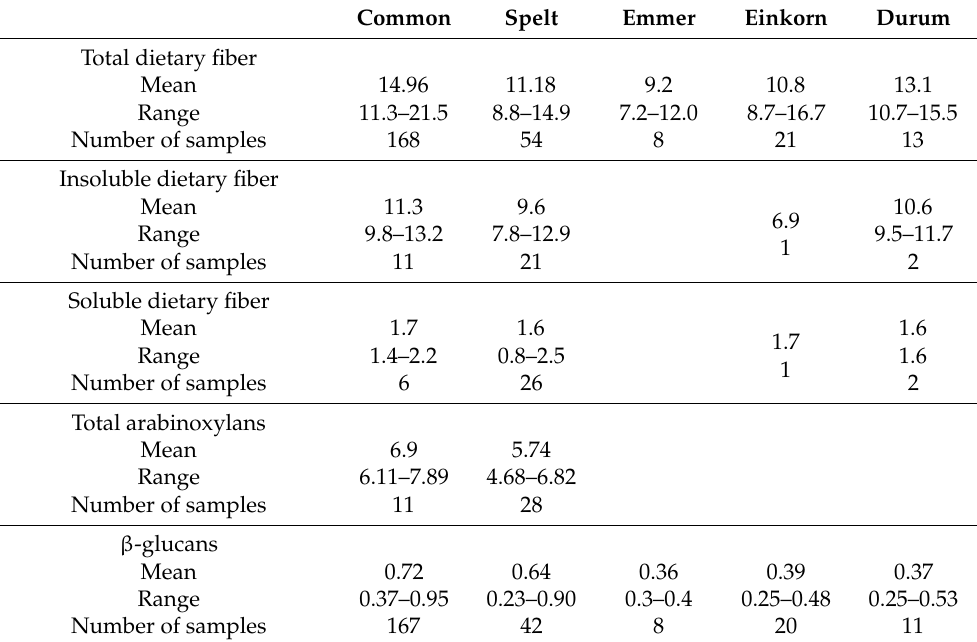
Table 3. Dietary fiber content (% dry basis) of modern (common and durum) and ancient (spelt, emmer and einkorn) wheats